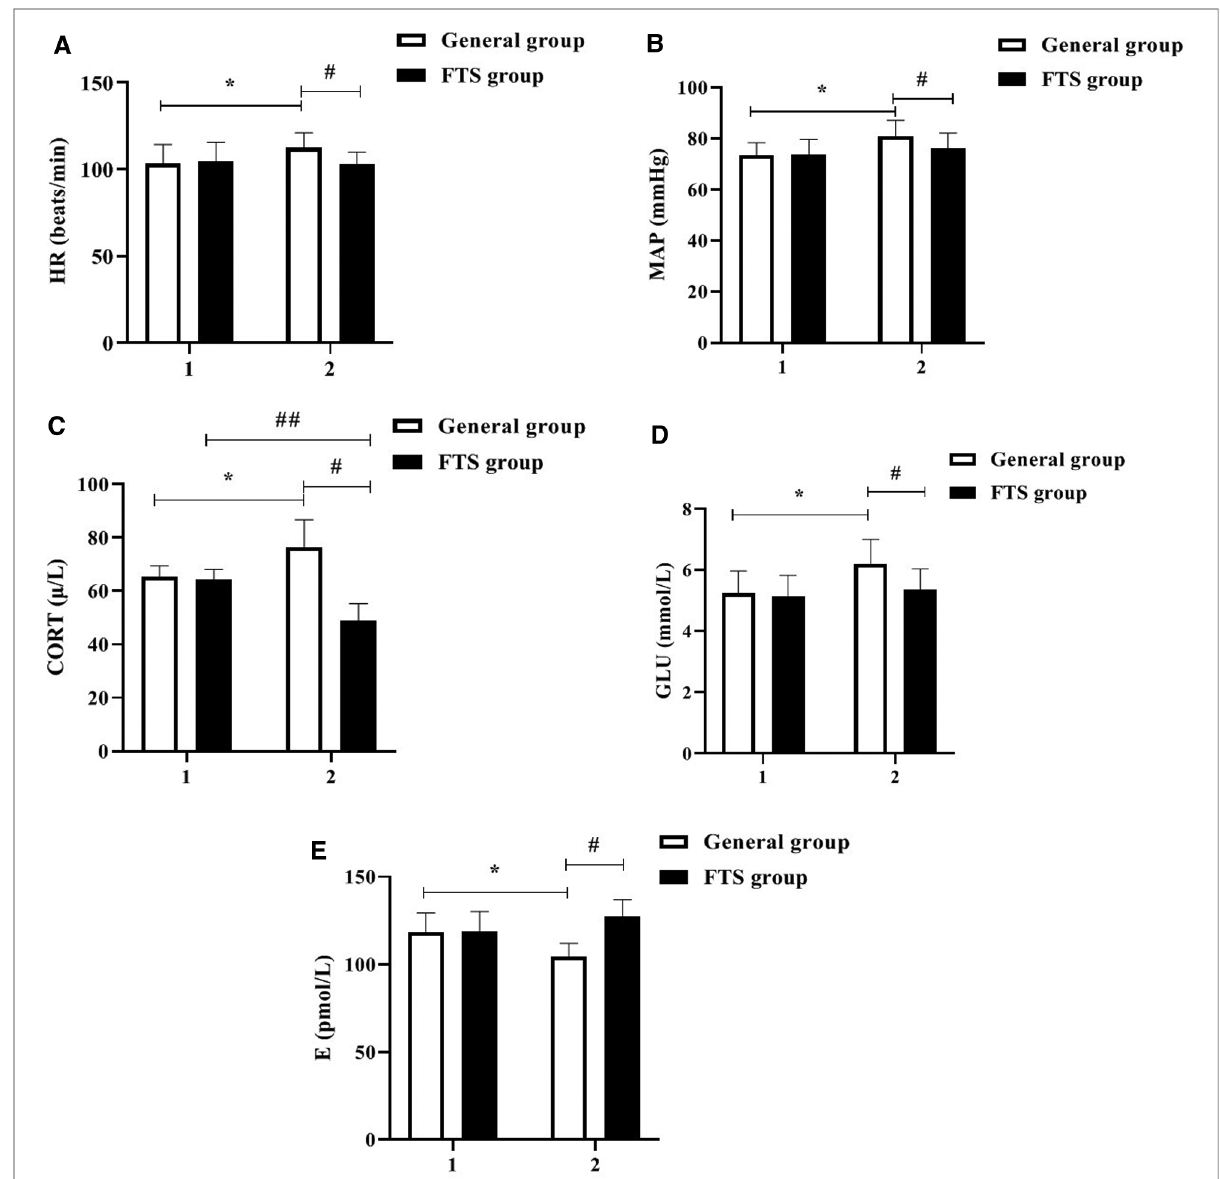
FIGURE 1 Comparison of hemodynamic indexes and stress hormone levels between the two groups before and after the intervention. In the fi gure, 1 represents before intervention and 2 represents after intervention. * Indicates the comparison of the general group before and after intervention, P <0.05; # Indicates the comparison of the FTS group with the general group after intervention, P <0.05; ## Indicates the comparison of the FTS group before and after intervention, P <0.05. Figure ( A-E ) shows the comparison of HR, MAP, COR, GLU, and E levels in the two groups,